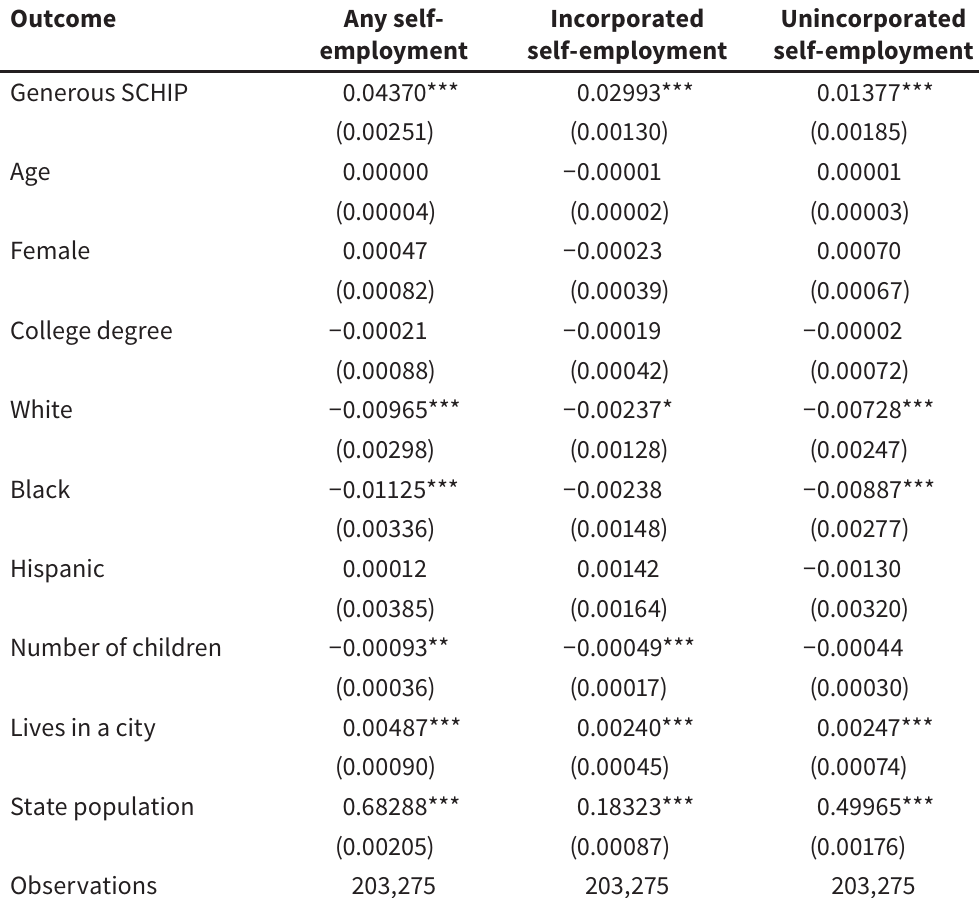
Heterogeneity in the Impact of Immigrant Entrepreneurs across Skill Levels